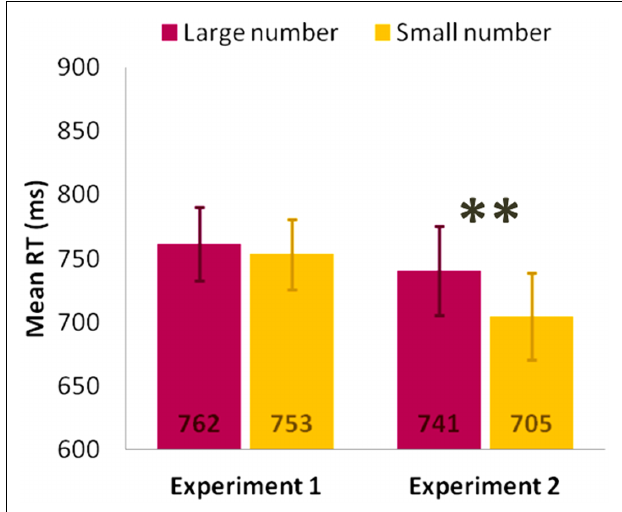
FIGURE 5 | Significant Numerical Magnitude × Experiment interaction , values are in millisecond and bars are SEM. Significant comparisons are indicated with *(p < 0.05) or **(p <